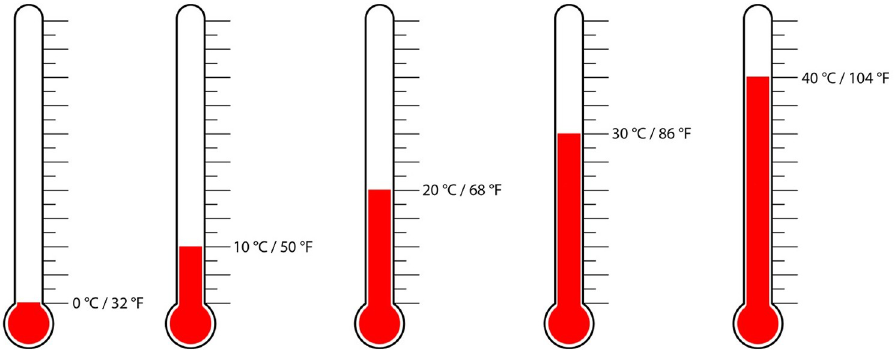
Fig 1. Temperature visual scales used in Experiment 1. The scales correspond to 0, 10, 20, 30, and 40 Degrees Celsius (˚C) and their equivalent in Degrees Fahrenheit (˚F).